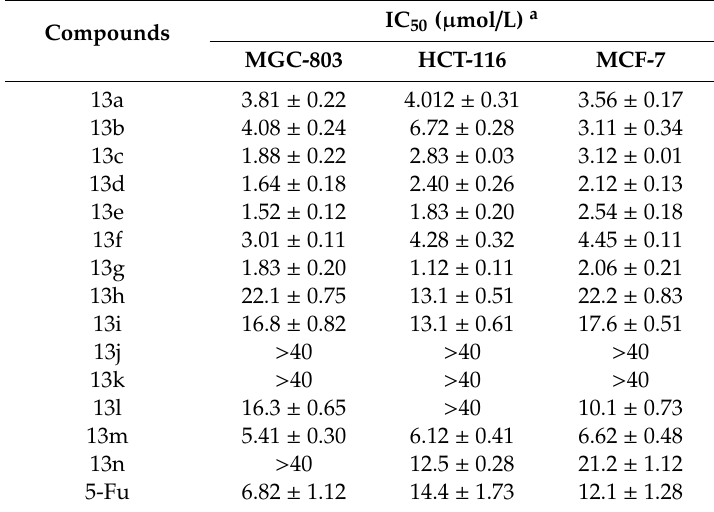
Table 1. In vitro antiproliferative activities of compounds 10a–p against human cancer